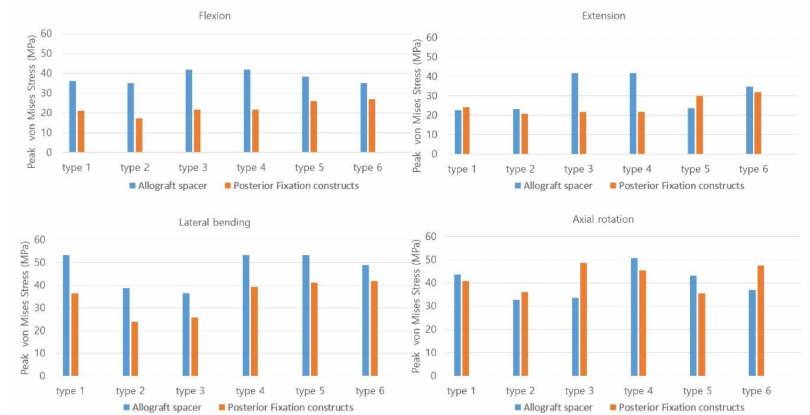
Figure 3. The Peak von Mises stress on the allograft spacers and posterior fixation constructs were dependent on the plate-screw combination. Type 1: all LMS, Type 2: all PS, Type 3: left (Lt) PS and right (Rt) LMS, Type 4: Lt LMS and Rt PS, Type 5: upper PS and lower LMS, and Type 6: upper LMS and lower